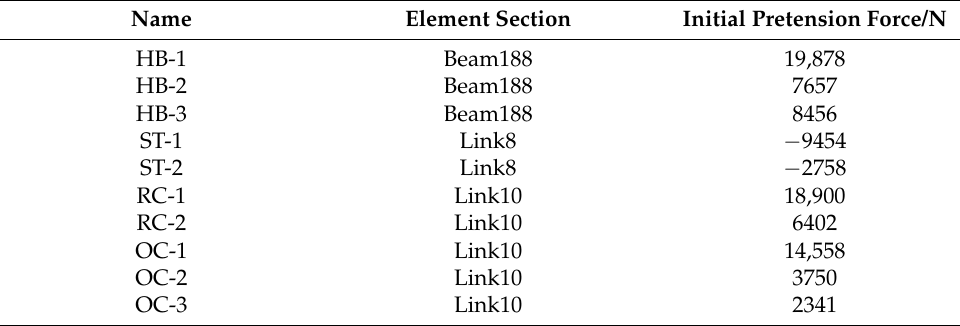
Table 2. Component specifications and initial prestress of the specimen.